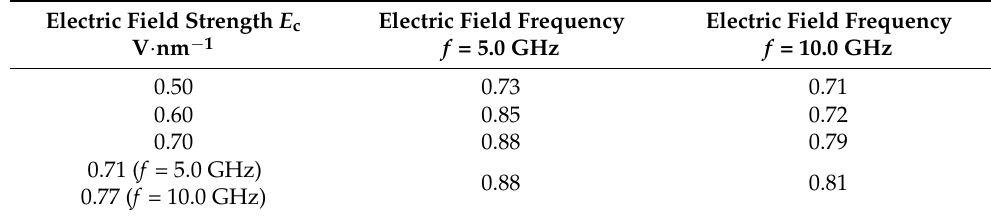
Table 3. The shrinkage function values of the two droplets under electric fields with different strengths and frequencies at t = 200